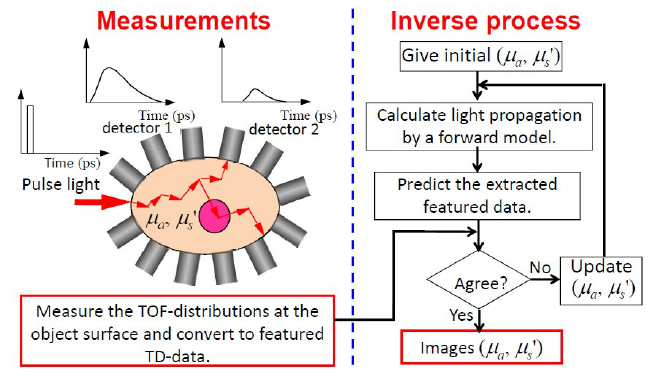
Figure 15. Standard process of MOBIIR for TD-DOT.